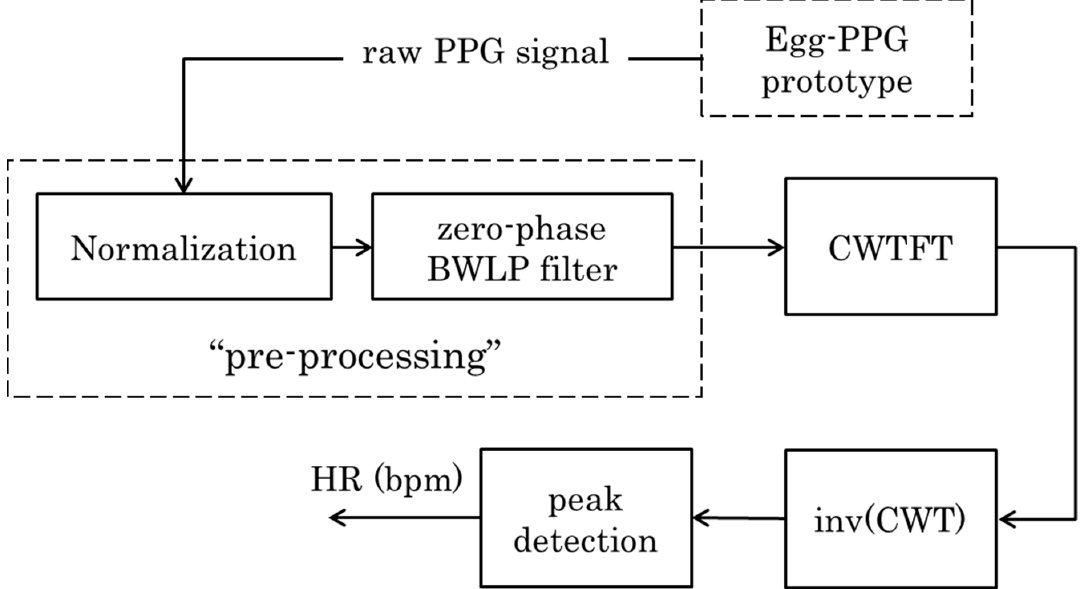
Figure 2. (left graph) a top-view schematic representation of the developed Egg-PPG prototype shows the relative positions of the three infrared LEDs ( L 0 , L 1 and L 2 ), photodiode ( P ) and the two sections (M 1 and M 2 ) of the Egg-PPG housing system ( HS ), (right graph) the corresponding photographic picture of the Egg-PPG prototype shows the photodiode and amplification circuit board ( AB ).